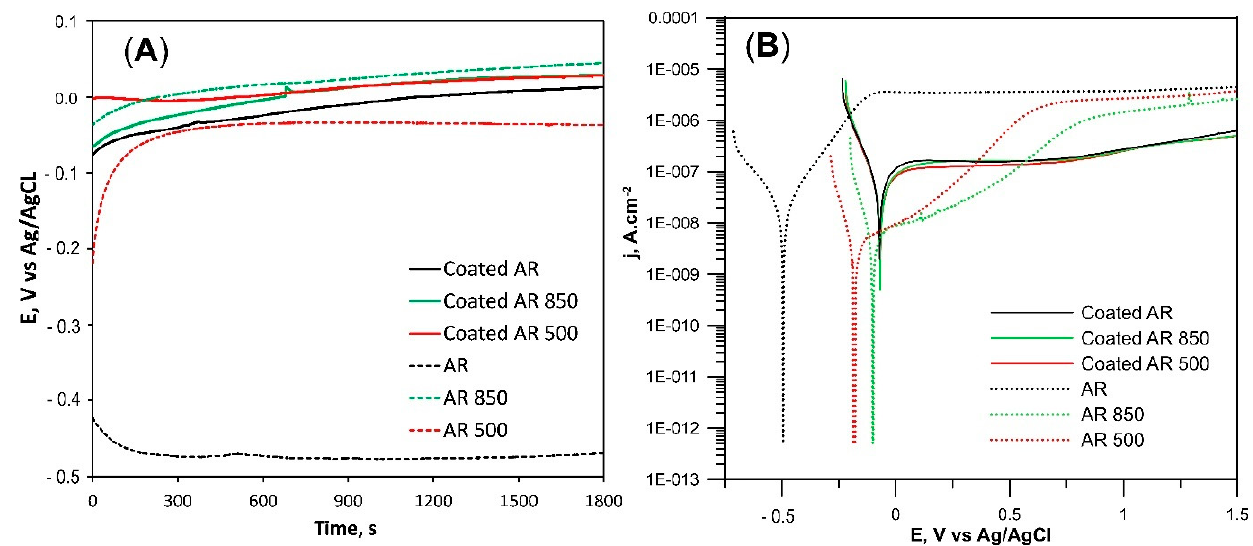
Figure 10. Representative open-circuit potentials ( A ) and potentiodynamic (PD) polarization curves ( B ) of the samples immersed in PBS at 37 °C.